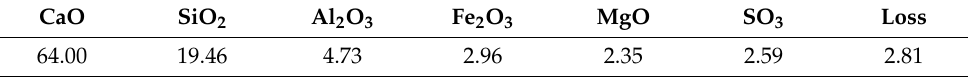
Figure 1. XRD pattern of P·II 52.5 Portland cement.